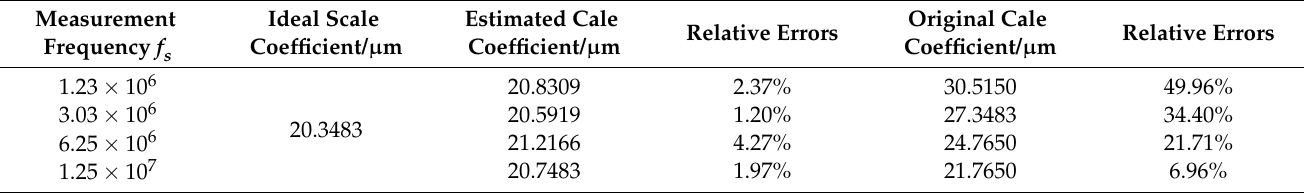
Table 10. Scale coefficient logG obtained by different methods and their relative errors between the ideal